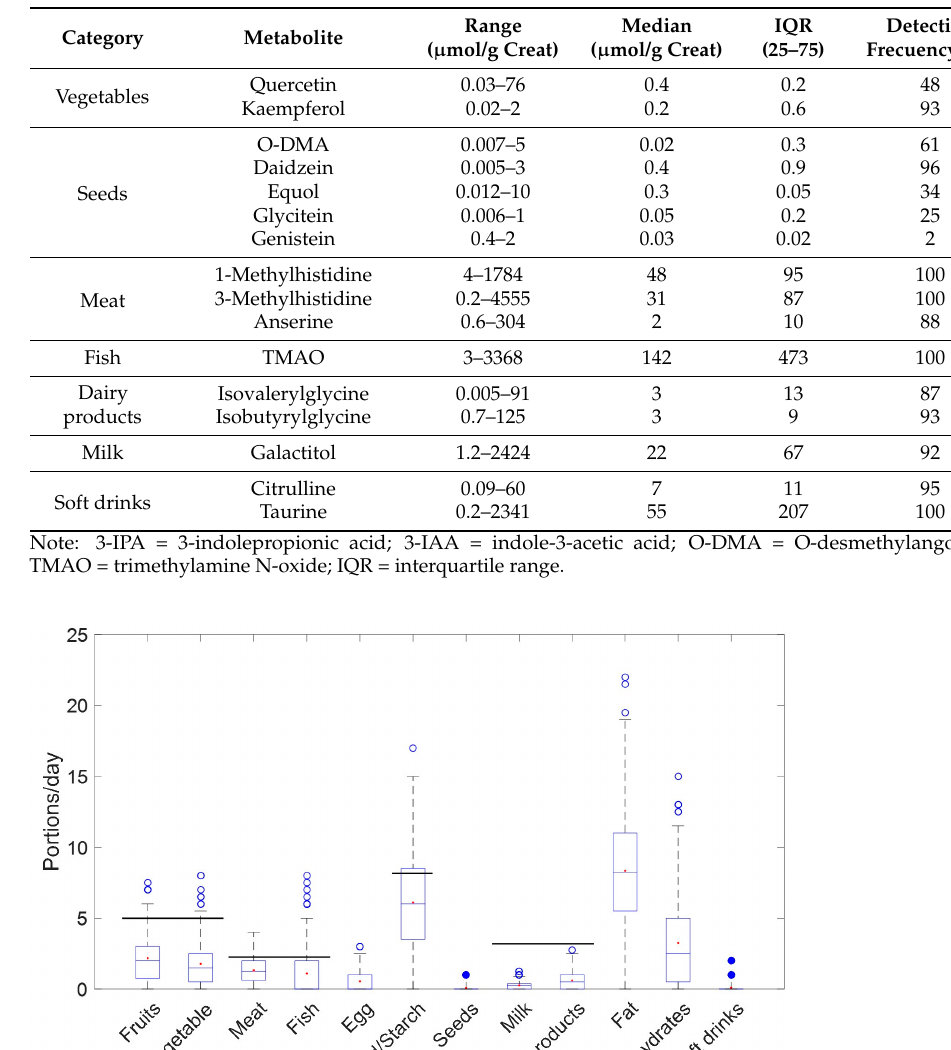
Table 2. Microbiota and nutrition biomarker concentrations in urine samples from lactating mothers.